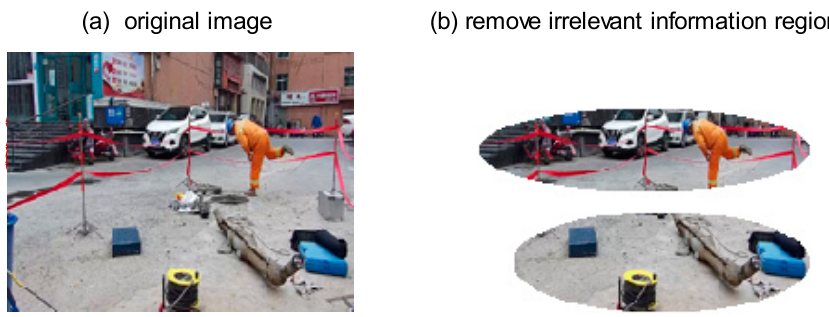
Figure 2. Filtering effect for irrelevant information on construction site.